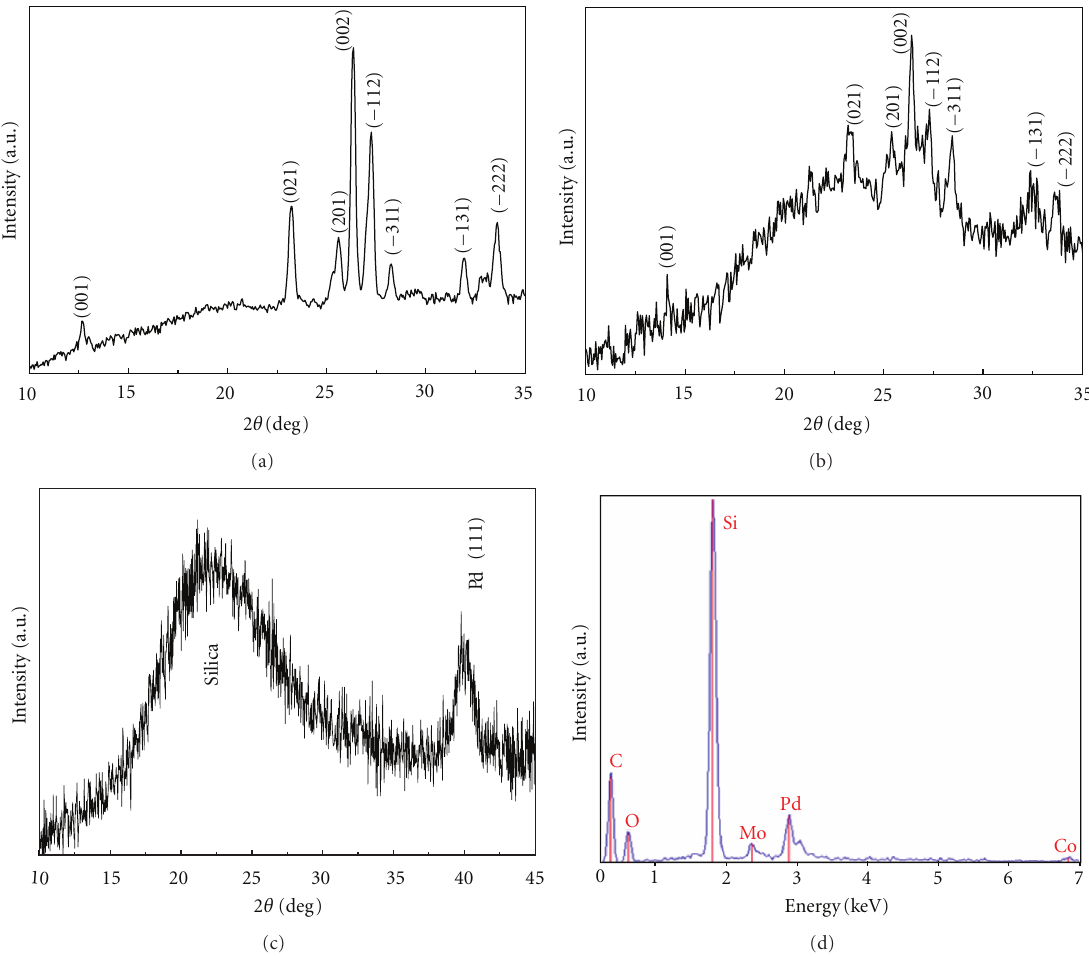
Figure 1: XRD patterns of CoMoO 4 (a), CoMoO 4 /silica (b), Pd/CoMoO 4 /silica (c), and EDX of Pd/CoMoO 4 /silica catalysts (d).